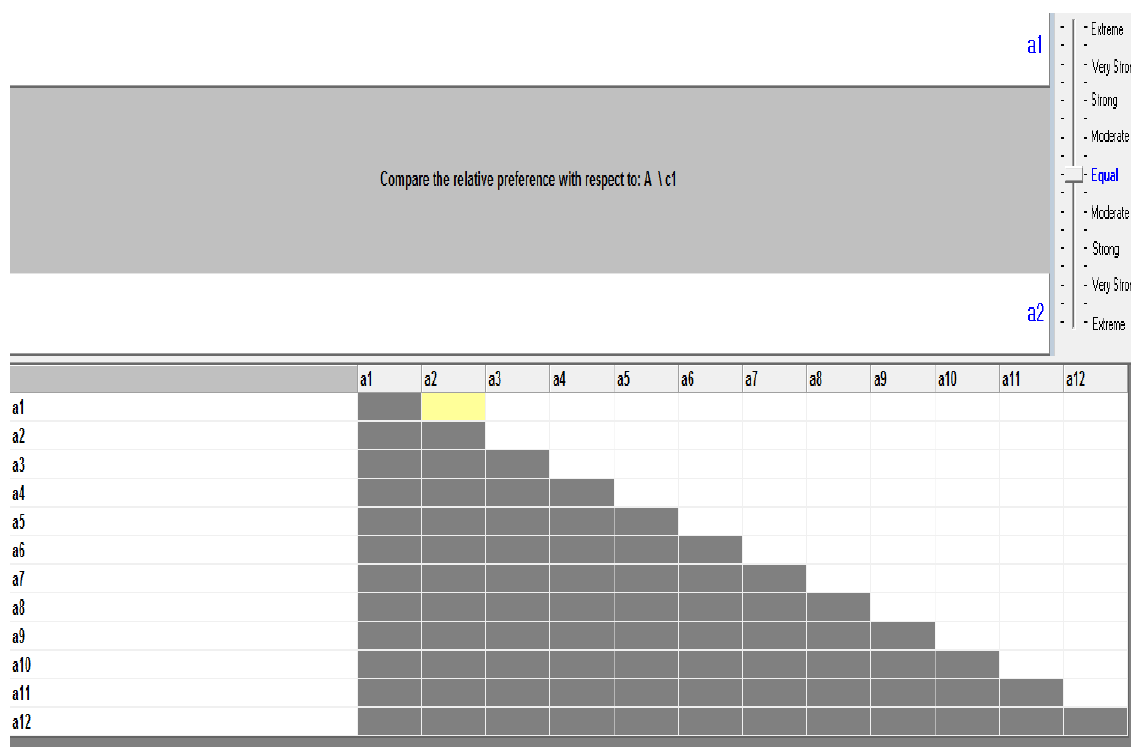
Fig. 2. Step 2: matrix of pairwise comparison of indicators based on the mode of expert